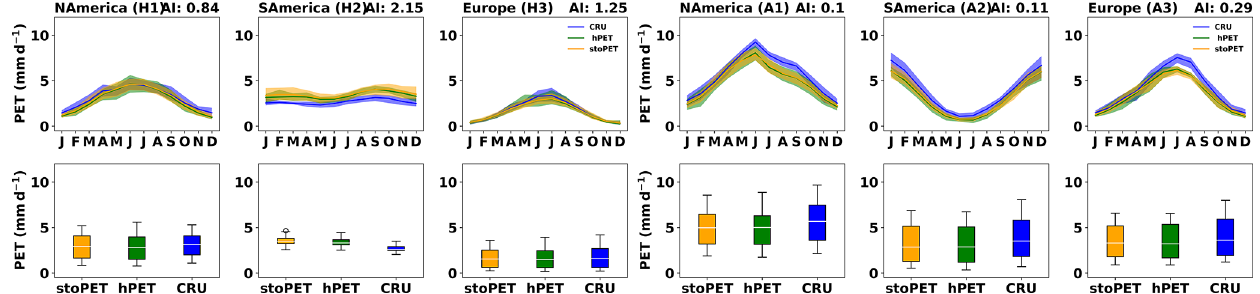
Figure 8. The seasonal PET and box plots for three datasets over North America, South America, and Europe for the (a) humid and (b) arid locations, as shown in Fig. 7. The box plots show the distribution of each dataset over the 20-year period. The box indicates the interquartile range (IQR; 25th–75th), while the upper whiskers are set to (75th + 1 . 5 × IQR), and the lower whiskers are set to (25th − 1 . 5 × IQR).